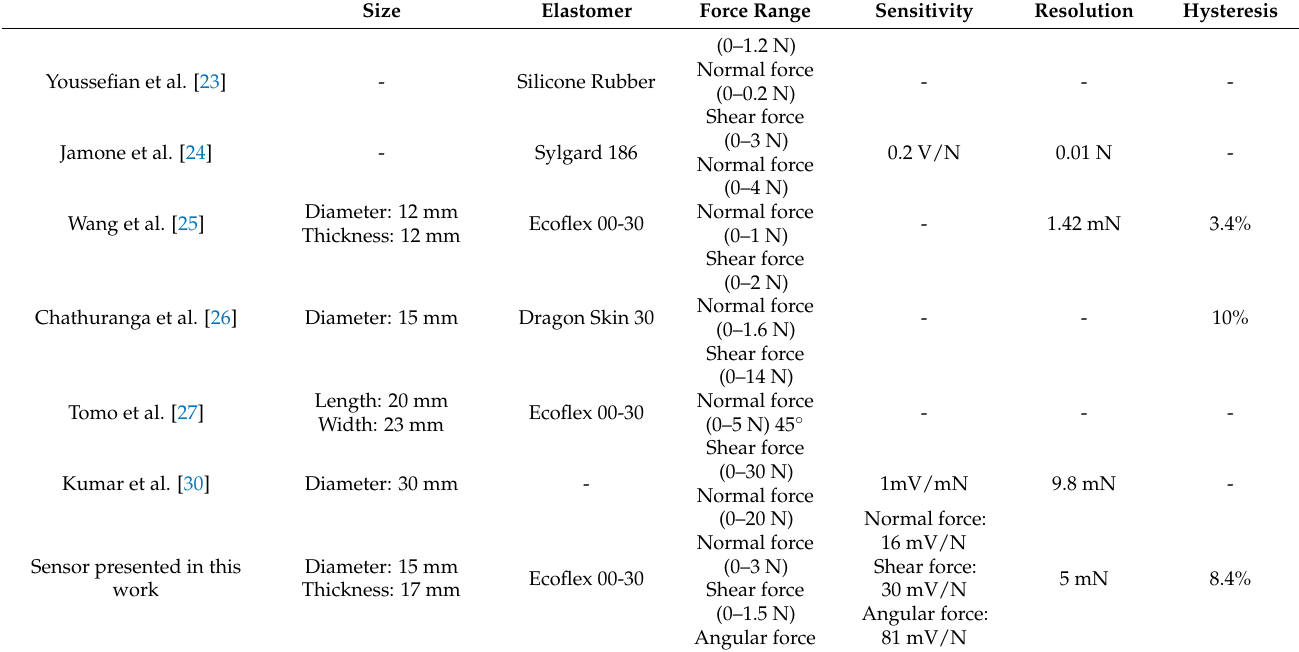
Table 3. Performance parameters of the proposed sensor in comparison with magnetic tactile sensors presented in the